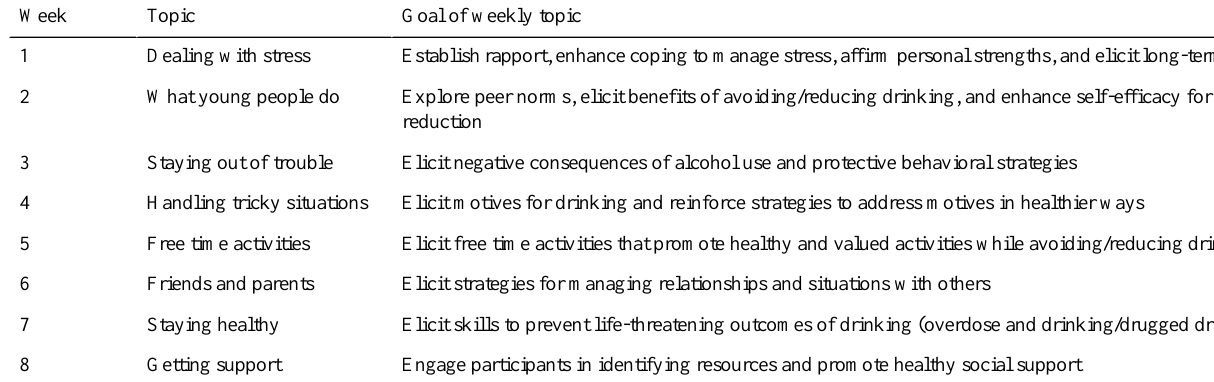
Table 1. Weekly content topics addressed in the social media interventions. Goal of weekly